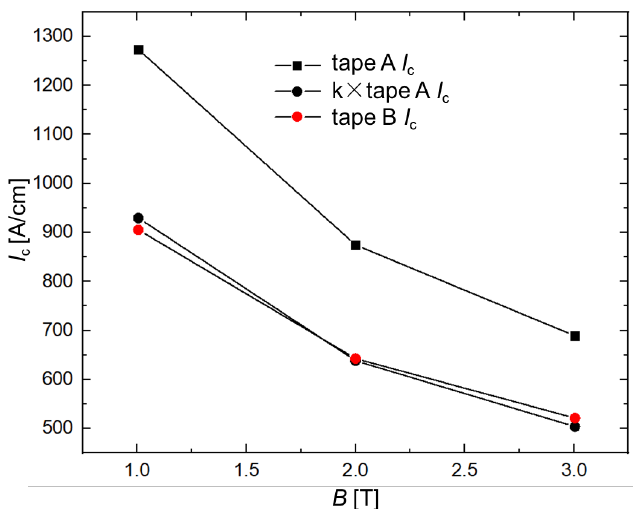
Figure 8. Estimation and verification of different type of HTS tapes’ I c − B − θ characteristics.